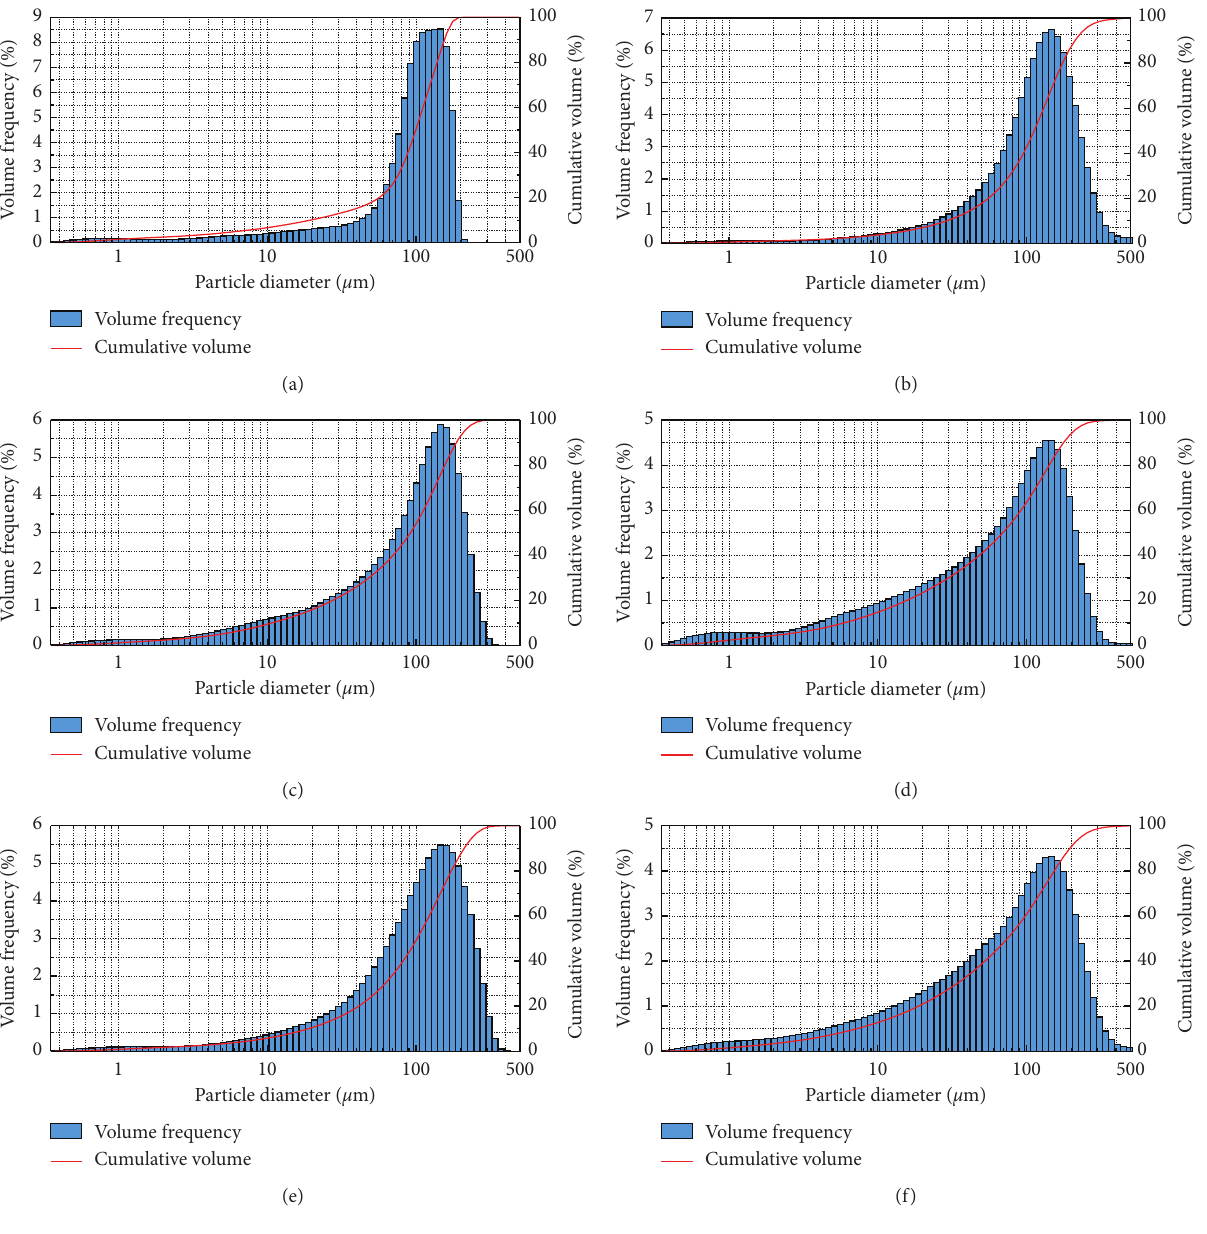
Figure 1: Particle size distribution of experimental coal samples: (a) lignite; (b) gas coal; (c) fat coal; (d) coking coal; (e) meager-lean coal; (f)